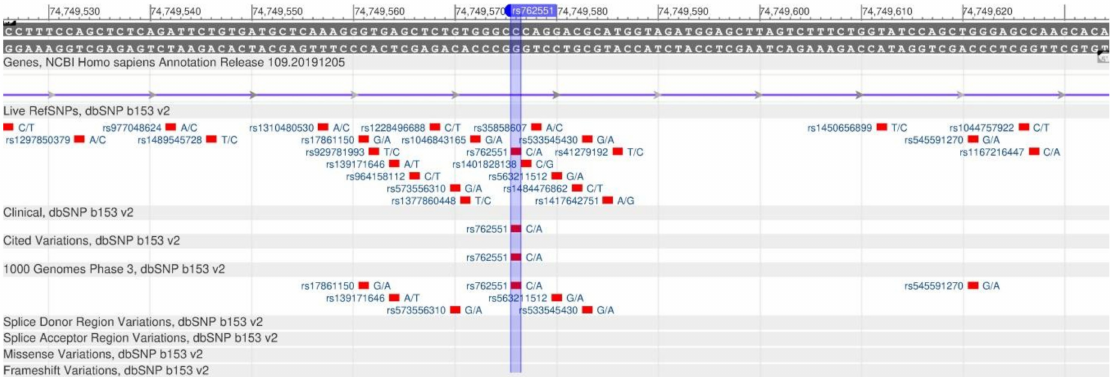
Figure 32. A plot of the CYP1A2 gene (located on the long (q) arm of chromosome 15) containing the oligonucleotide polymorphism rs762551.